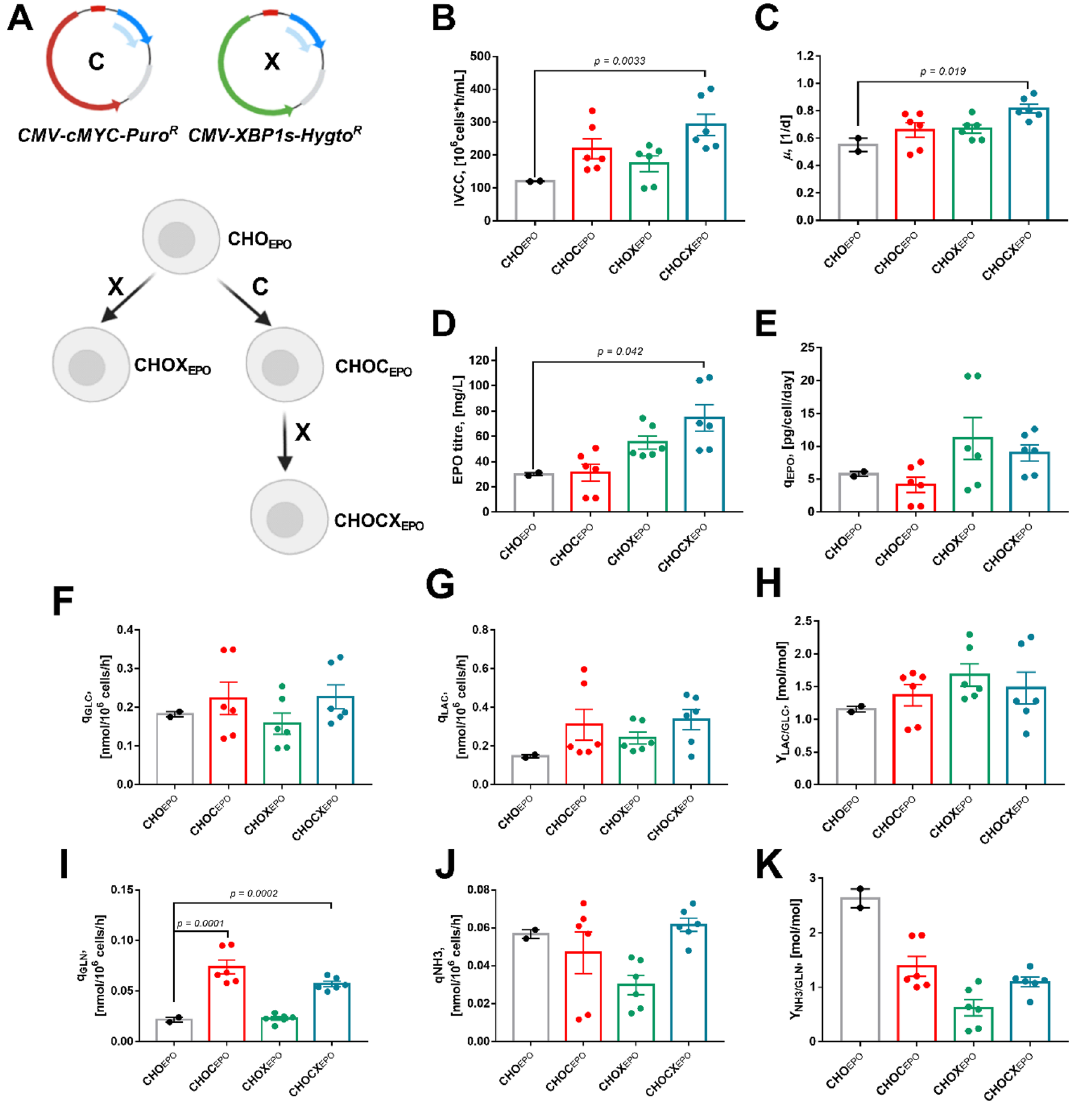
Figure 2. Development of a MYC and XBP1s overexpressing CHO cell line. ( black ) CHOEPO cell line; ( red ) CHOC EPO cell line; ( green ) CHOX EPO cell line; ( blue ) CHOCX EPO cell line. ( A ) Overview of the cell engineering strategy to overexpress MYC and XBP1s in the CHO EPO cell line. The CHOXC EPO cell line was generated by transfecting cells with the CMV-MYC-Puro R and the CMV-XBP1s-Hygro R plasmid, and isolating cells resistant to puromycin and hygromycin in the culture medium. Additionally, the CHOC EPO and CHOX EPO cell lines were generated as control cell lines. ( B ) Integral of viable cell concentration (IVCC). ( C ) cell-specific growth rate (µ). ( D ) EPO titre. ( E ) cell-specific EPO productivity (q EPO ). ( F ) Glucose consumption rate (q GLC ). ( G ) Lactate production rate (q LAC ). ( H ) Ratio of lactate produced to glucose consumed (Y LAC/GLC ). ( I ) Glutamine consumption rate (q GLN ). ( J ) Ammonia production rate (q NH3 ). ( K ) Ratio of ammonia produced to glutamine consumed (Y NH3/GLN ). Each dot corresponds to the duplicates (n = 2) of the three isolated cell clones. p values (One-way ANOVA) below to 0.05 indicate the statistical significance of parameter expression of the recombinant EPO, MYC and XBP1s genes (Fig. 3D–I). Whilst we found no relationship between the mRNA expression of the recombinant EPO and/or MYC genes and EPO productivity (Fig. 3D,E), the XBP1s mRNA expression presented a slight correlation with the EPO titres (Pearson’s correlation, R = 0.6, p = 0.006) (Fig. 3F). Moreover, we only observed a slight correlation between the MYC mRNA levels and the IVCC (Pear- son’s correlation, R = 0.61, p = 0.004) (Fig. 3H), while the mRNA expression of EPO and XBP1s did not present any relationship with cell growth variations of the cell lines (Fig. 3G–I). These results indicated that MYC and XBP1s overexpression had a positive influence on cell proliferation (Figs. 2B,C, 3H) and EPO secretion in our engineered CHO cell lines, respectively (Figs. 2D,E, and 3F). It is also interesting to note that XBP1s overexpres- sion was more effective for increasing EPO production when co-expressed with MYC (Figs. 2D and 3F).